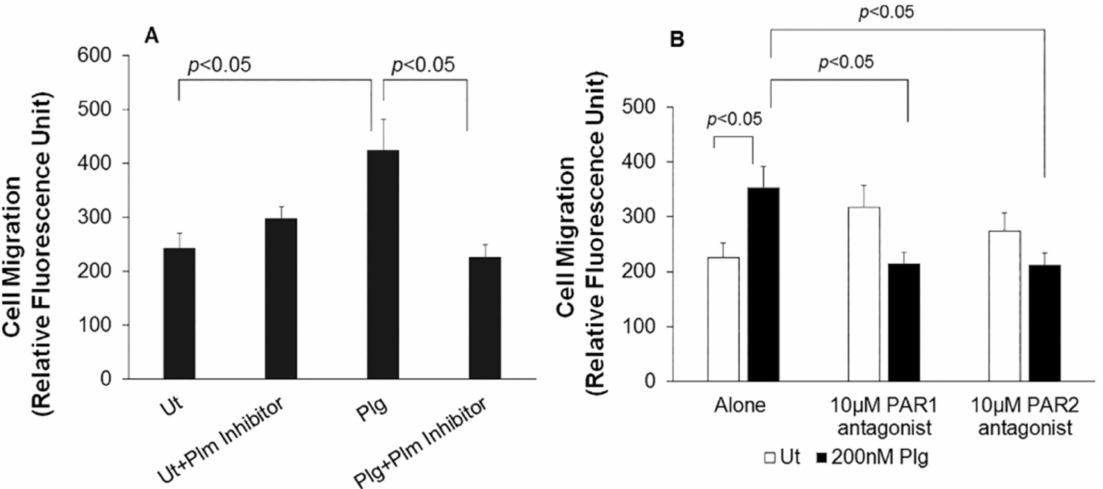
Figure 1. Plasminogen enhances endothelial migration using PAR1 and PAR2. Starved HUVECs, untreated (Ut) or treated with Plg, were allowed to migrate as described in “Material and Methods”. “Alone” denotes HUVECs in diluent of DMEM: F12 + 0.1% BSA. Cells, the Plm inhibitor and PAR antagonists were resuspended in this same medium. ( A ) Plg induced significantly higher endothelial cell migration compared to Ut HUVECs, and this increase was significantly inhibited by an irreversible Plm inhibitor, D-Val-Phe-Lys chloromethylketone dihydrochloride. ( B ) Effects of PAR1 and PAR2 antagonists on HUVEC migration in the presence or absence of Plg. Data are representative of 3 independent experiments, each containing at least triplicates. Values are means ±